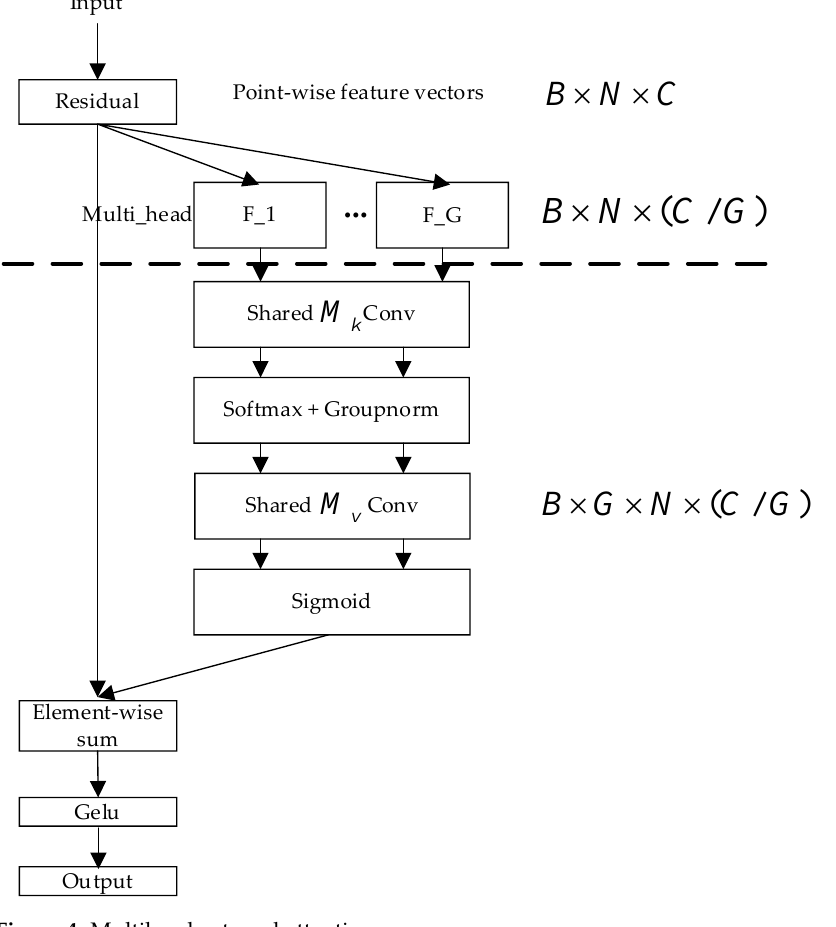
Figure 4. Multihead external attention.